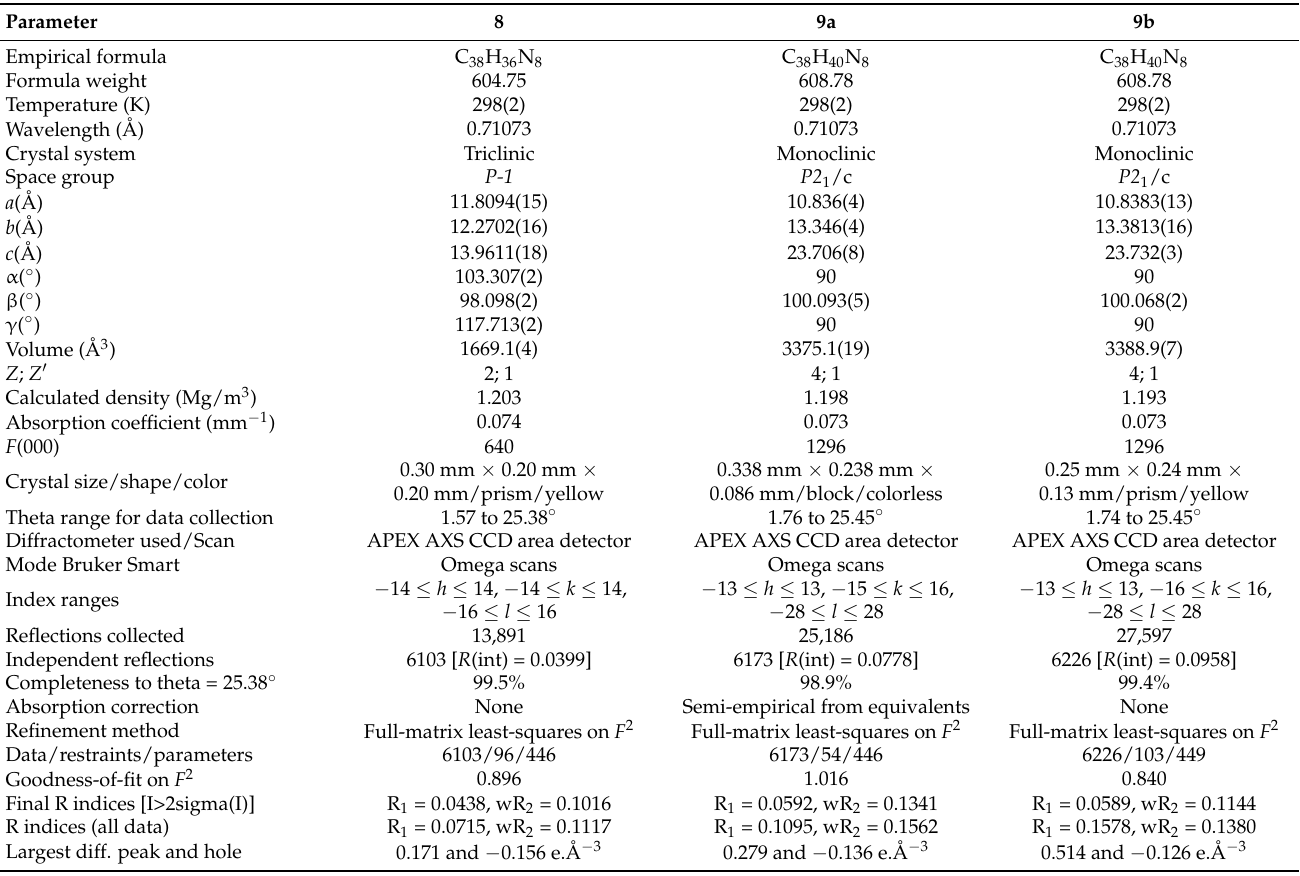
Table 1. Single crystal X-ray diffraction data and the refinement parameters for compounds 8 , 9a , and 9b